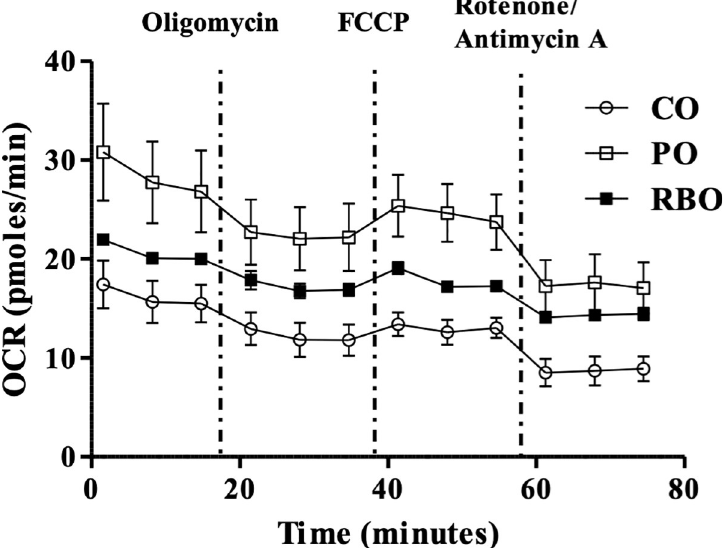
Fig 6. Real-time OCR quantification of M1-induced BMDM isolated from experimental diet-fed mice. Appropriate drugs were used to control mitochondrial respiration.